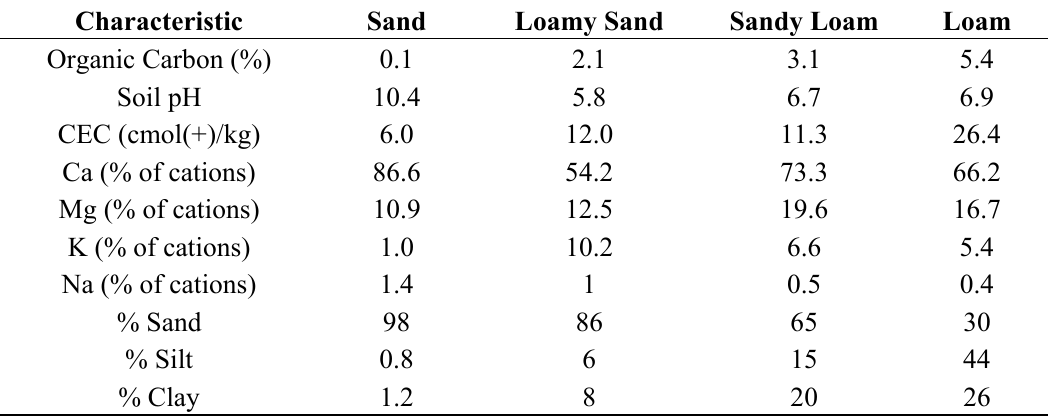
Table 2. Soil characteristics for the four soils considered in sorption batch tests. CEC is the cation exchange